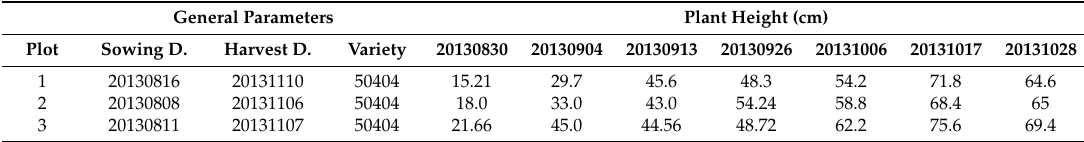
Table 2. Example of rice plant parameters measured at some sample rice fields. General Parameters Plant Height (cm)